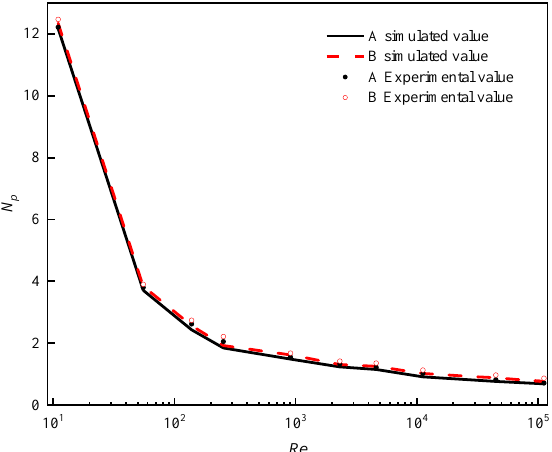
Figure 5. Curve of the power criterion versus the Reynolds number.